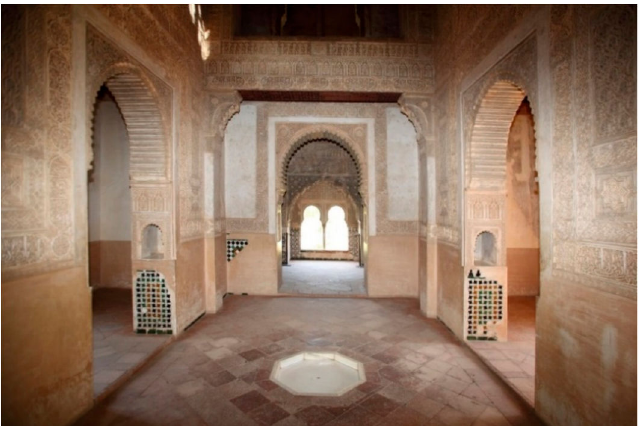
Figure 4. Interior of the Tower of the Princesses, showing fine plasterwork and alicatados from the reign of Muhammad VII (1392–1408), considered historiographically to be a period of decadence. © Mar í a Elena D í ez Jorge, 2014.